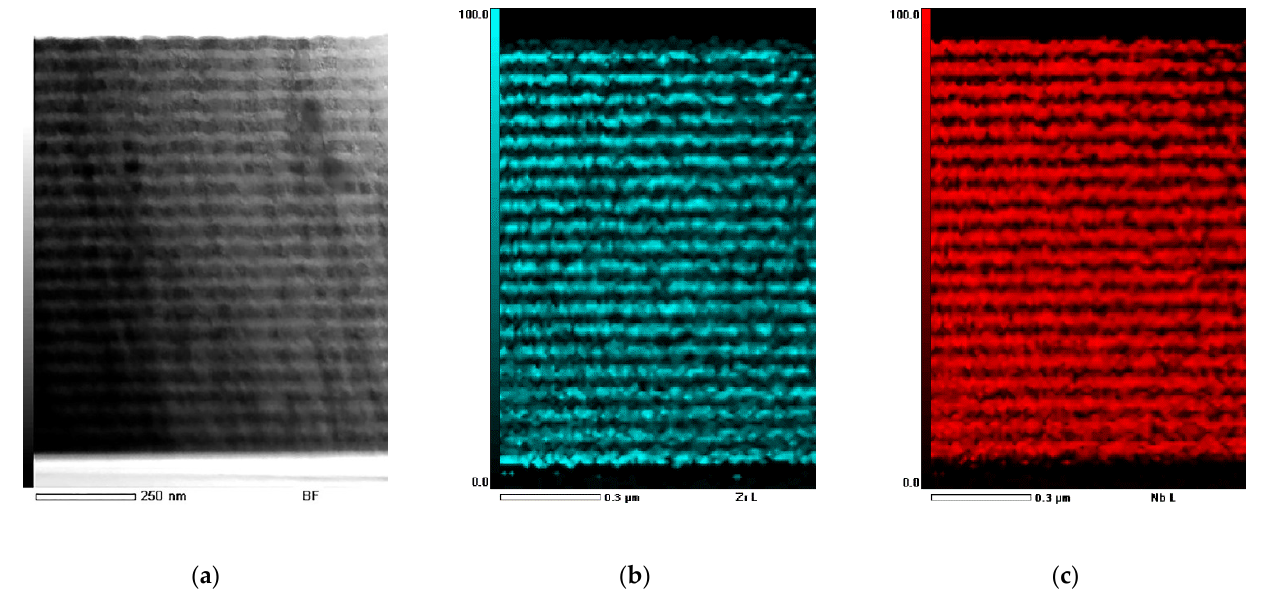
Figure 2. Cross-section TEM image ( a ) and EDS-mapping of Zr (blue) ( b ) and Nb (red) ( c ) layers of the as-deposited Zr/Nb NMCs.